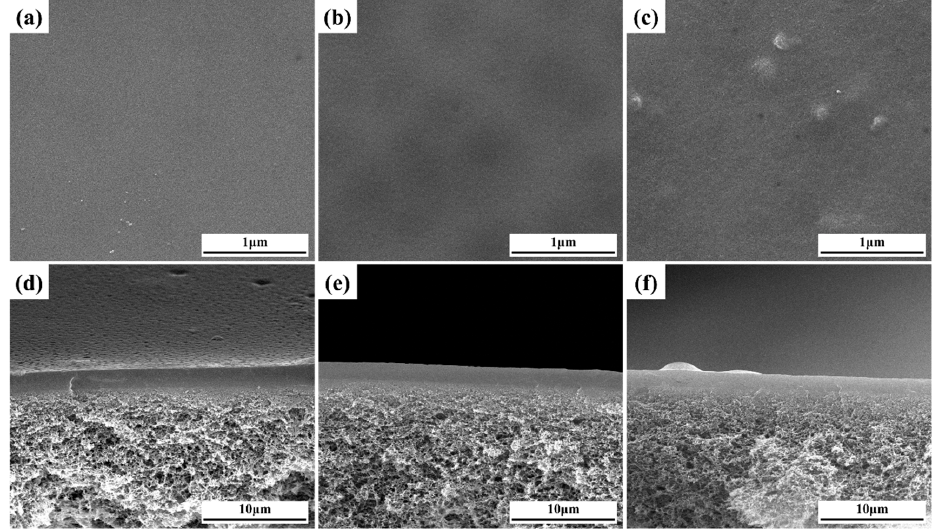
Figure 4. ( a – c ) top-surfaces and ( d – f ) cross-sections of the PVA, PG, and PGM-0 composite mem-